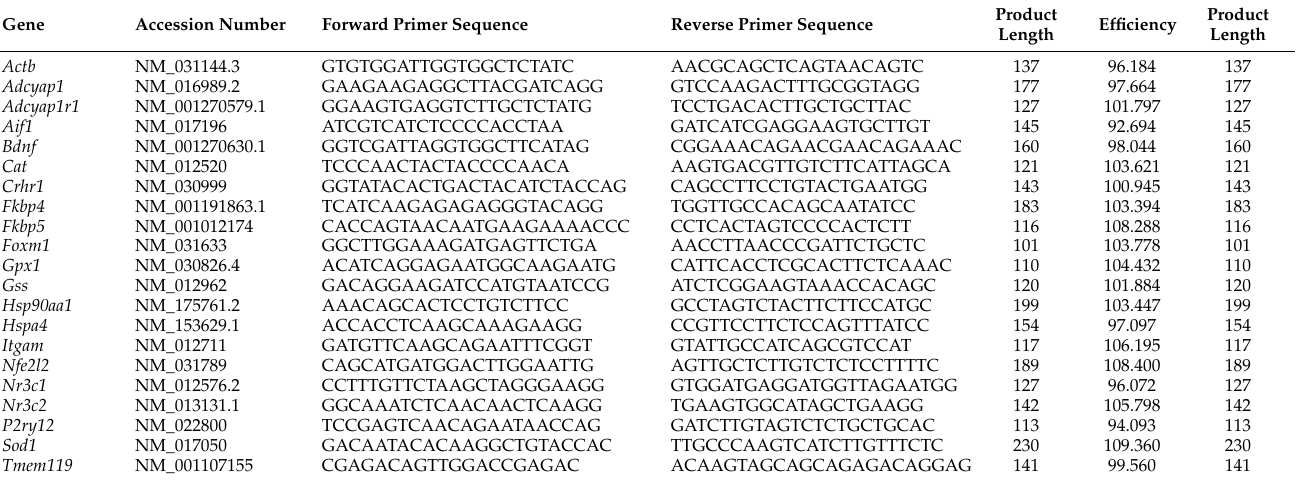
Table 2. List of PCR